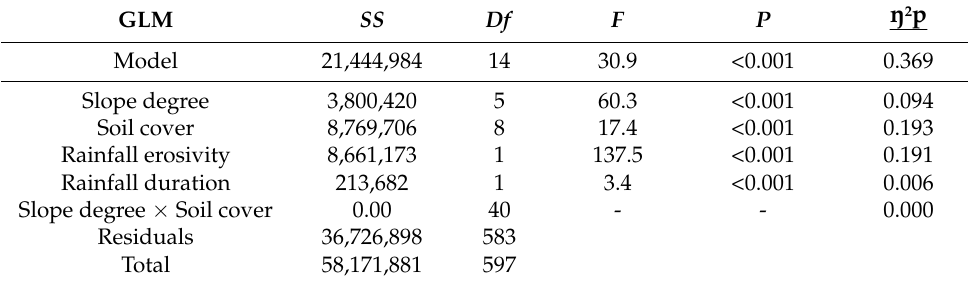
Note: SS represents sum of squares, Df represents the degrees of freedom, F represents the statistic value, p represents significance, and